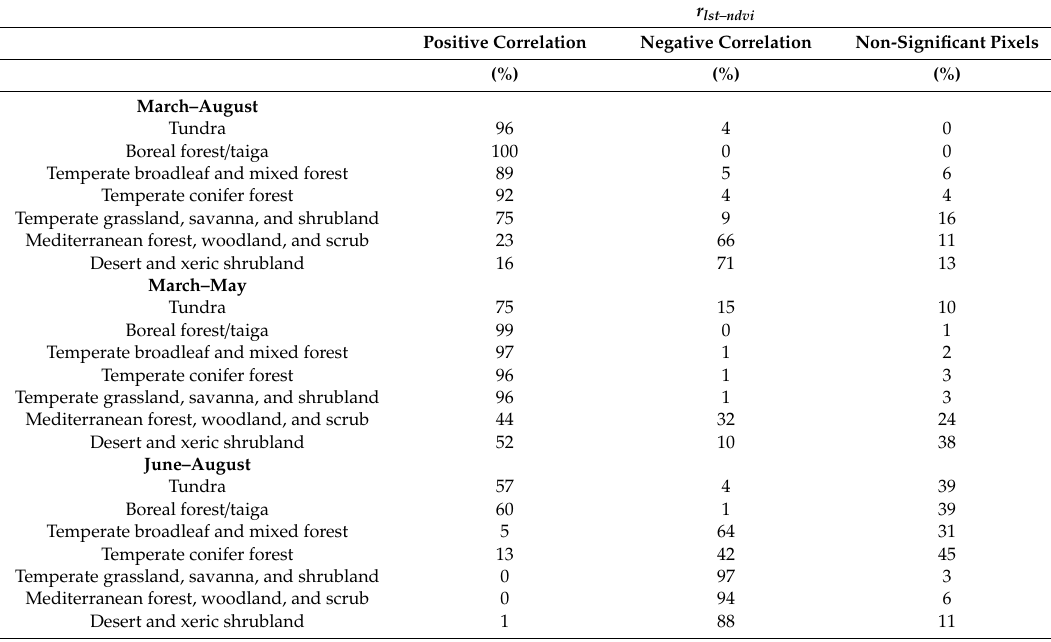
Table 1. Percent of positive, negative, and non-significant pixels covering each of the biomes from March–August, March–May, and June–August. Bold values indicate values higher than